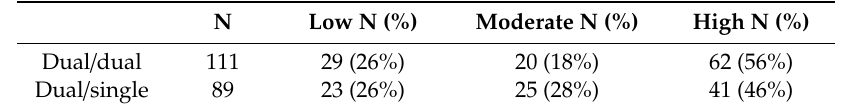
Table 3. Scintigraphy “responder confidence” per parathyroid. N = number of hyperfunctioning parathyroid glands found using each